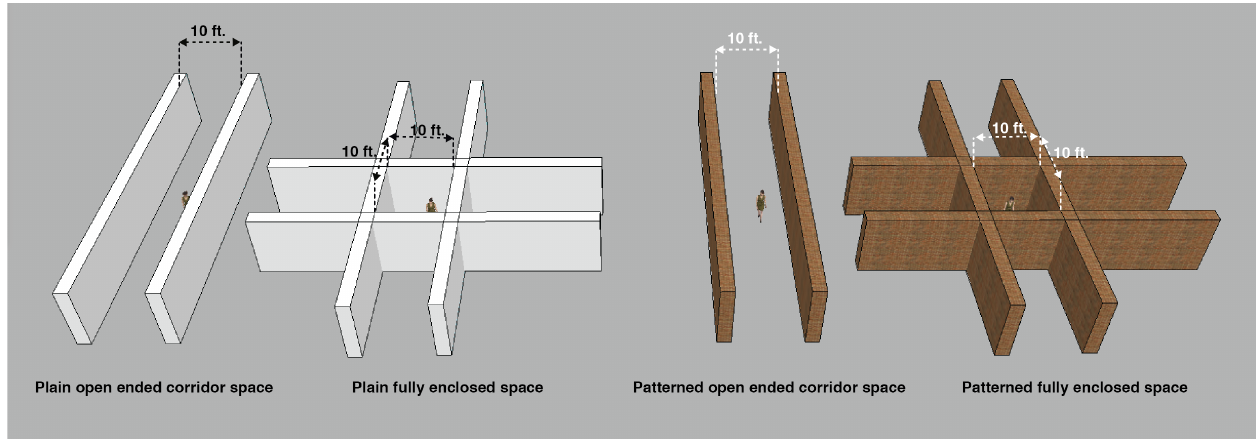
Figure 3. A set of models developed for the